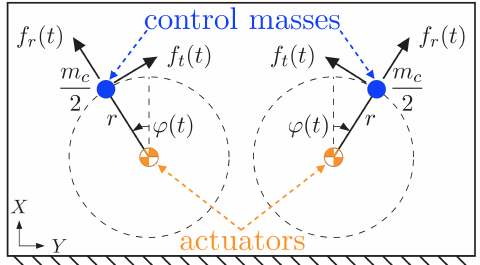
Figure 1. Layout of twin rotor damper (TRD)